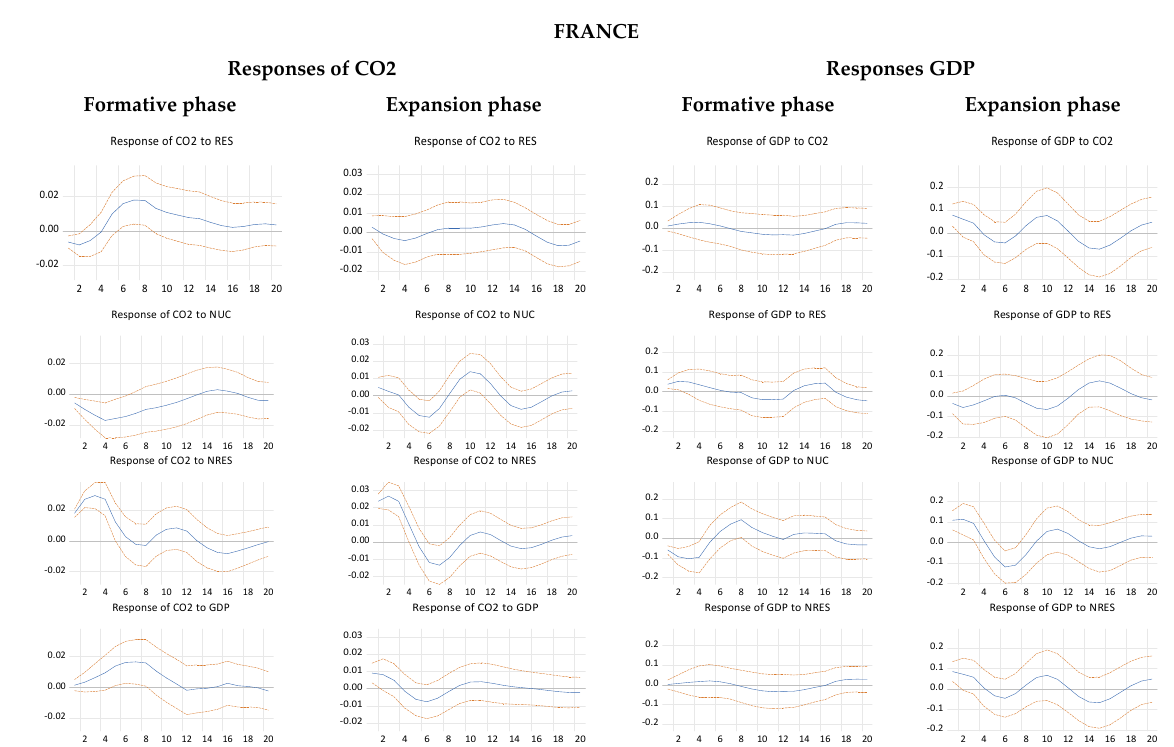
Energies 2021 , 14 , x FOR PEER REVIEW